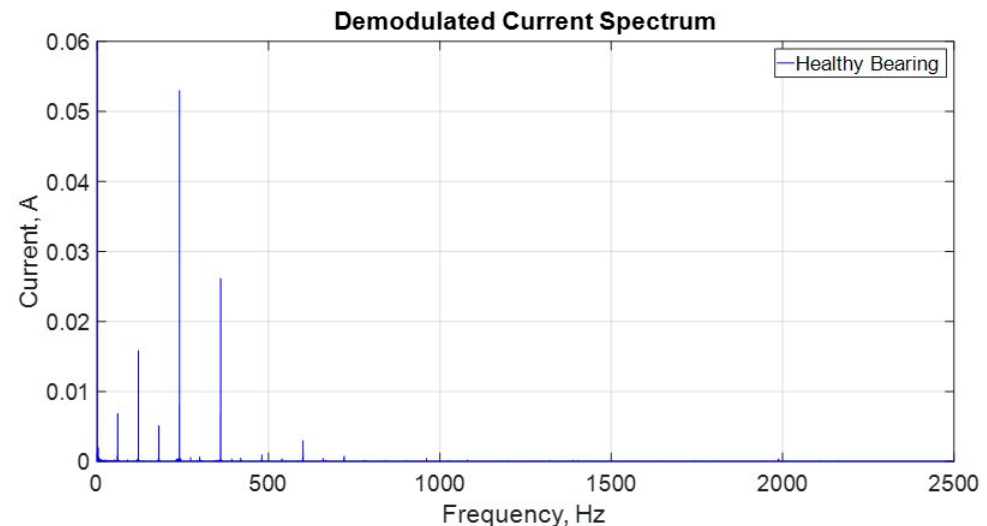
Figure 8. Demodulated current spectrum for the motor with a faulty bearing.